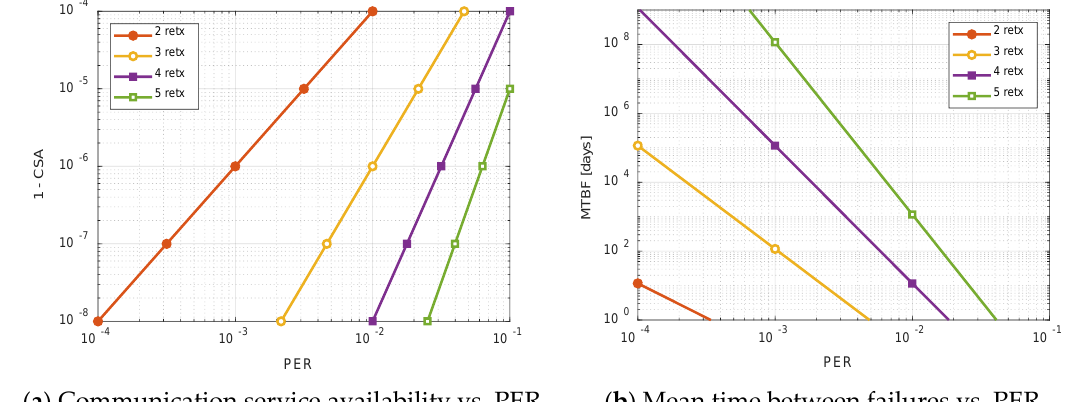
Figure 2. Communication service availability (CSA) and mean time between failures (MTBF) as a function of the packet error rate (PER) and the number of possible retransmissions ( retx ) for L = 10 ms.